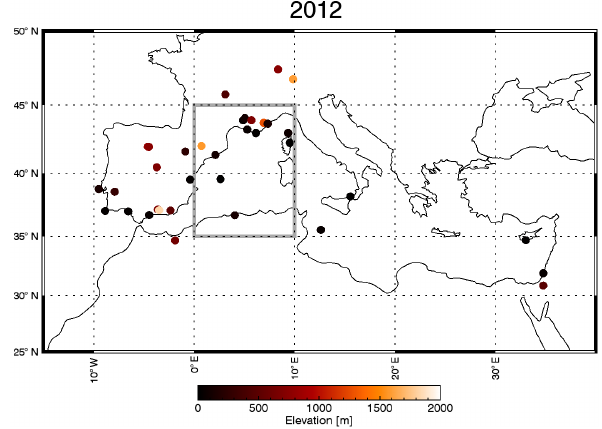
Figure 5. Positions of AERONET stations used in this study for the period of the TRAQA campaign in the northern summer of 2012. The grey box marks the region from which we considered SEVIRI data used in Fig. 3 and Table 2. The colours represent elevation of the stations as marked on the colour